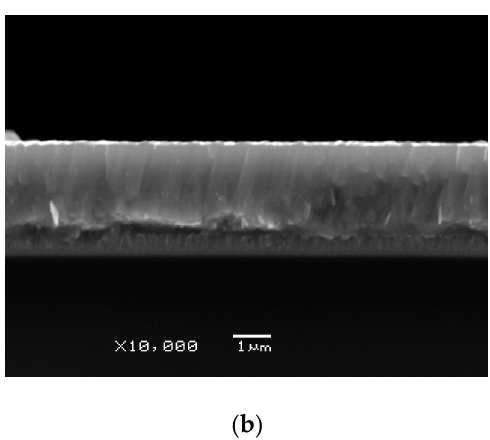
Figure 1. The structure and morphology of Zr–C coatings with carbon content in the range of 0–50 at.%: ( a ) X-ray diffractograms of the coatings, ( b ) SEM cross section image [15].